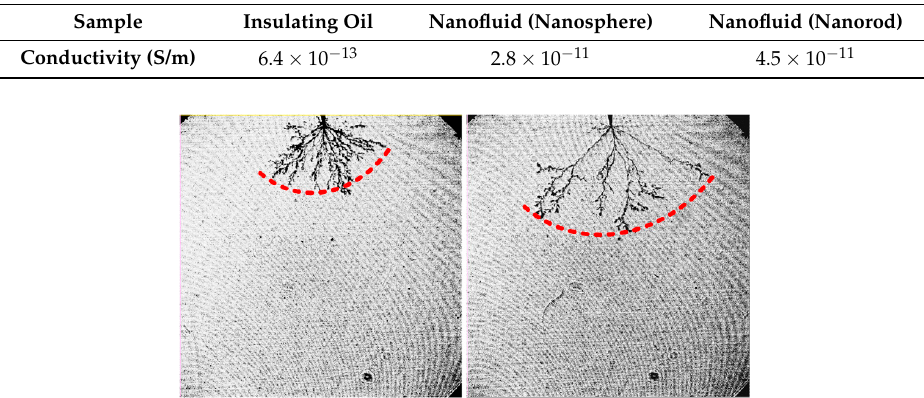
Figure 8. Streamers of nanofluid with nanorods.